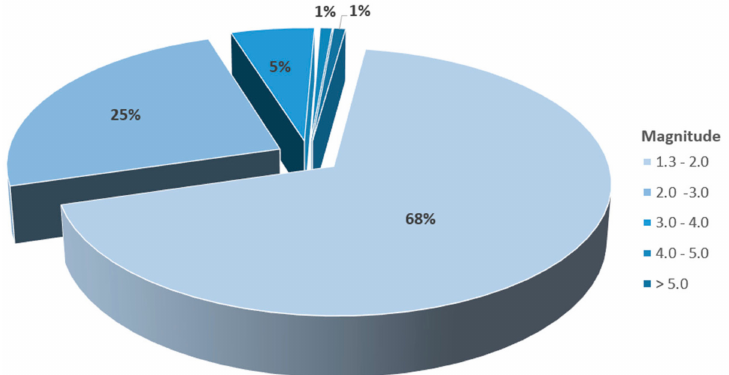
Figure 5. Percentage of earthquakes of each magnitude interval that occurred in the epicentral area of the Zagreb earthquake in the period from 22 March to 1 April